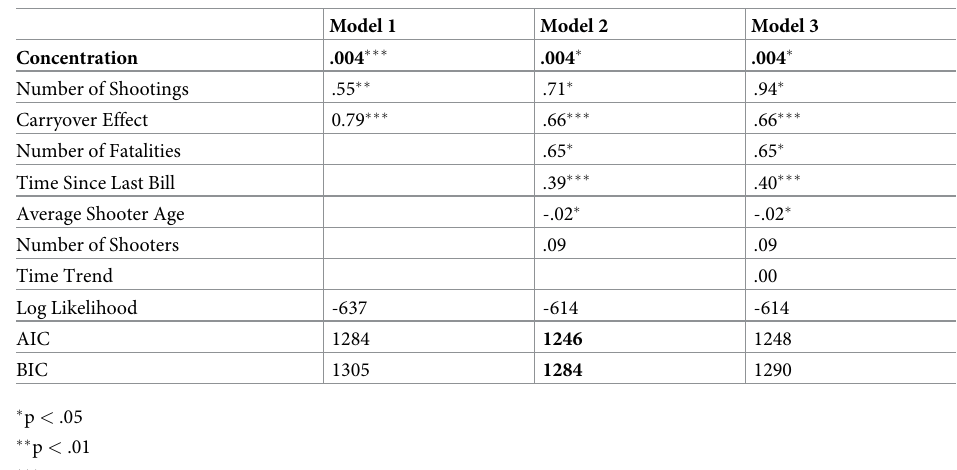
Table 1. Concentration of mass shootings and gun control bills